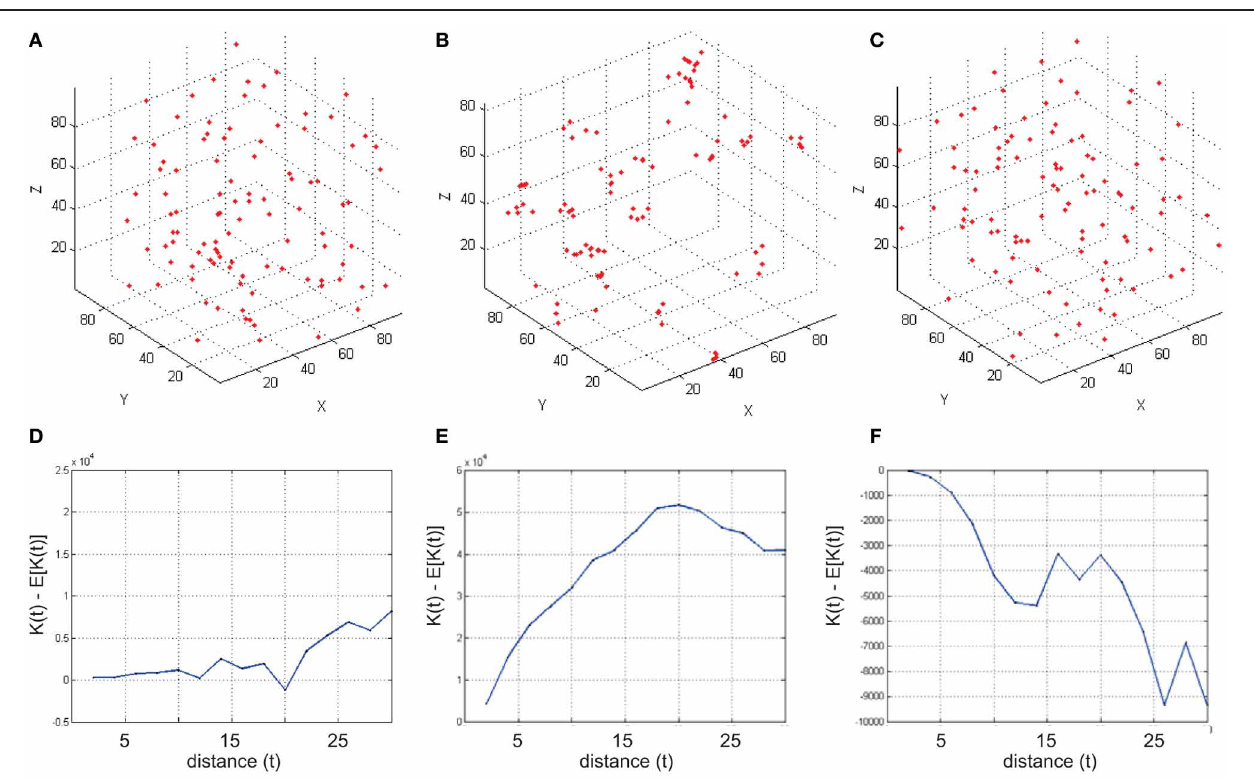
FIGURE 2 | Examples of simulated reference cell distributions. (A,D) The Homogenous Poisson Process [Complete spatial randomness (CSR)]. The difference ˆ K ( t ) – E [ ˆ K ( t )] is close to 0 and we cannot discard that the sample